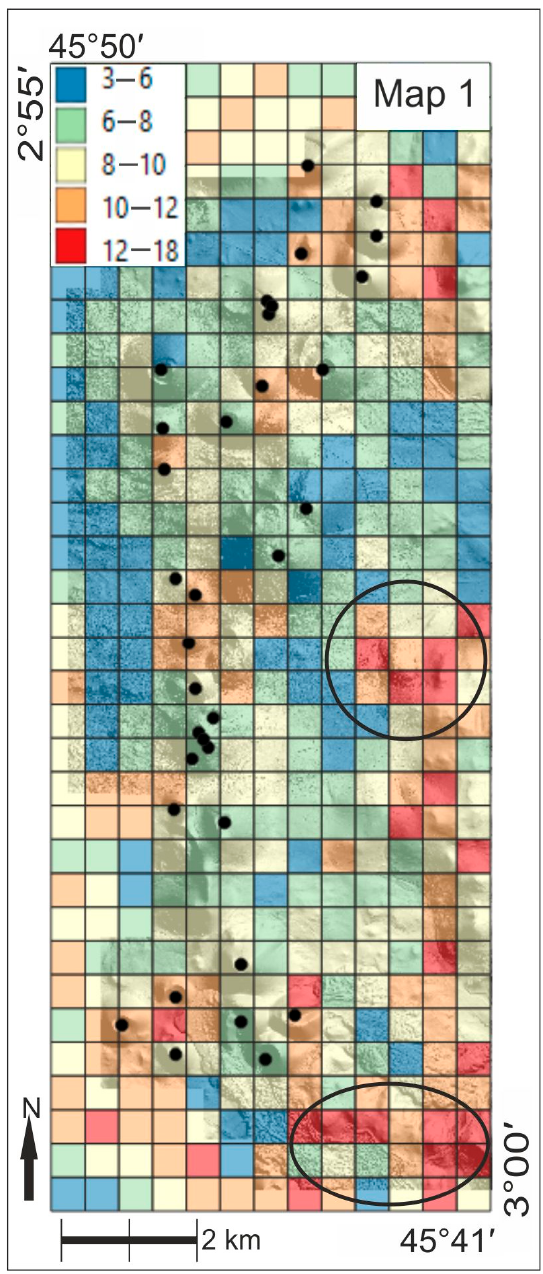
Figure 8. Geodiversity map of the examined area (Map 1). The values were calculated according to the original method [4] but with the use of geomorphons. Black dots indicate the scoria cone centers. The oval indicate basement areas with high geodiversity values.